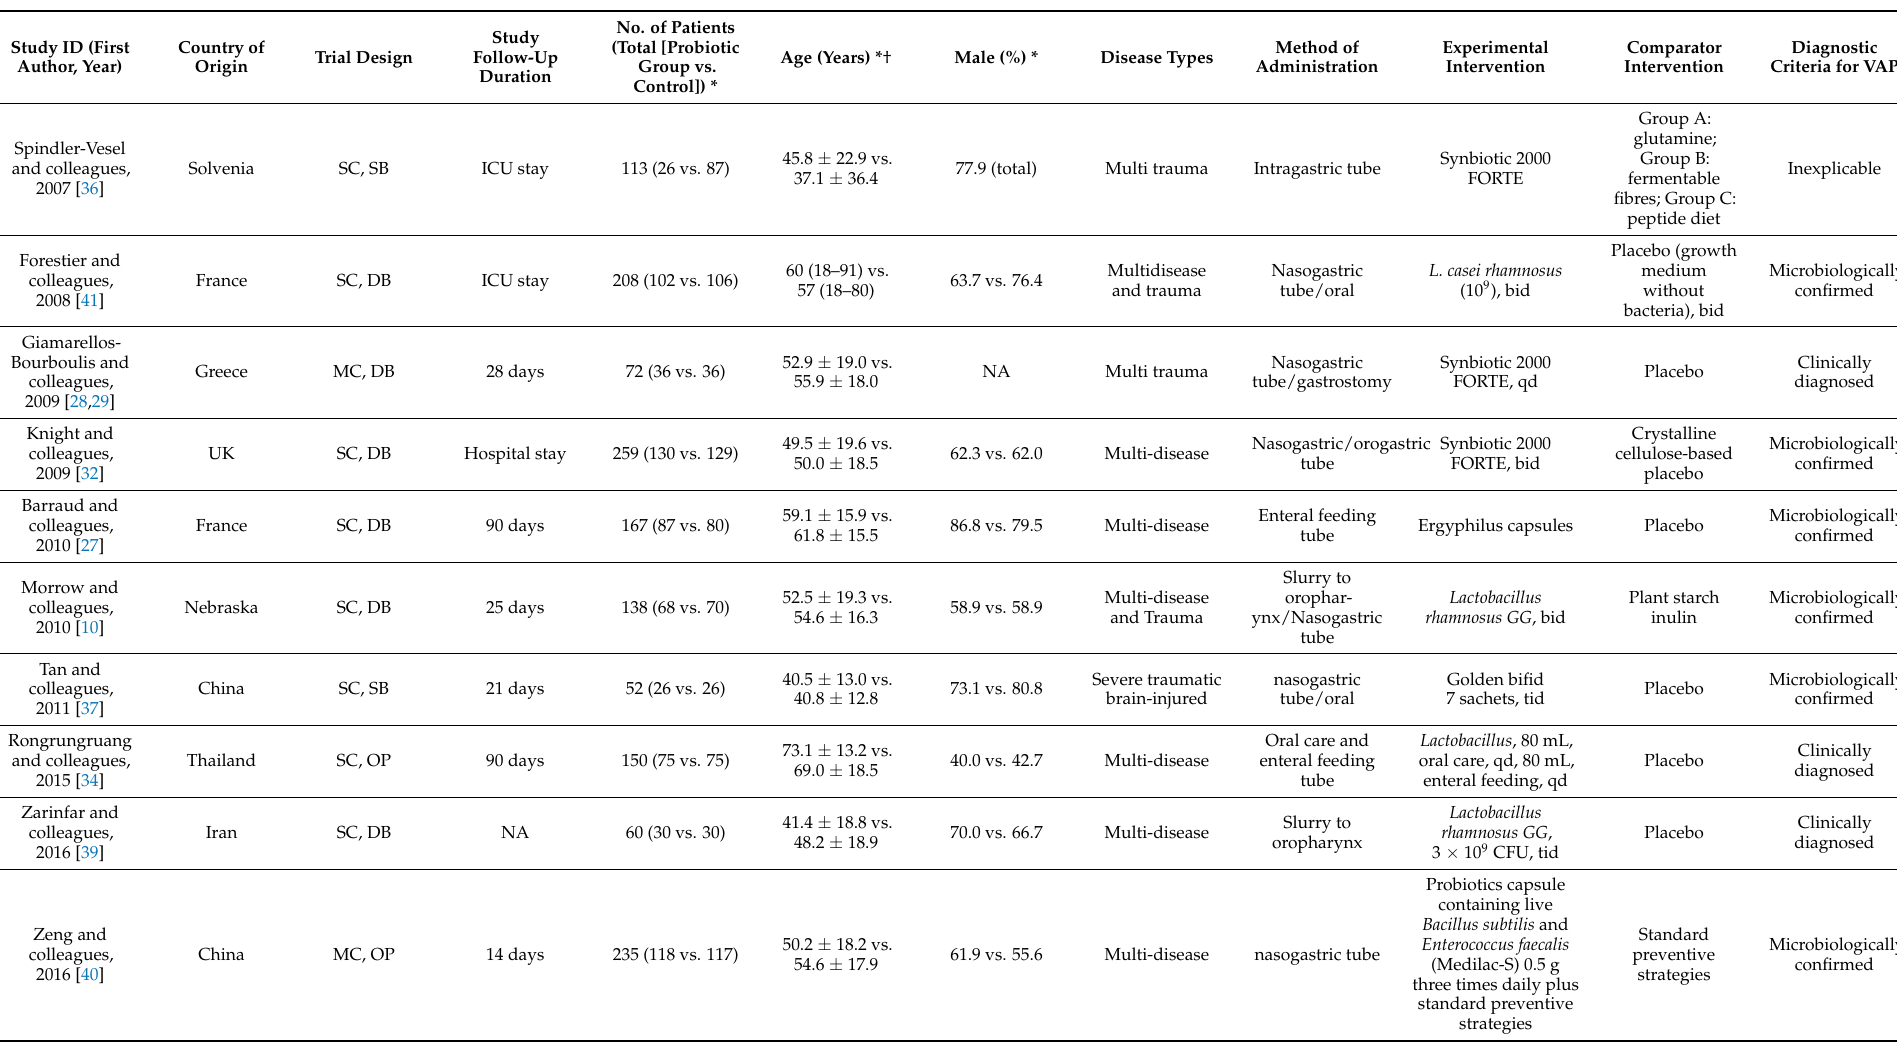
Table 1. Characteristics of included